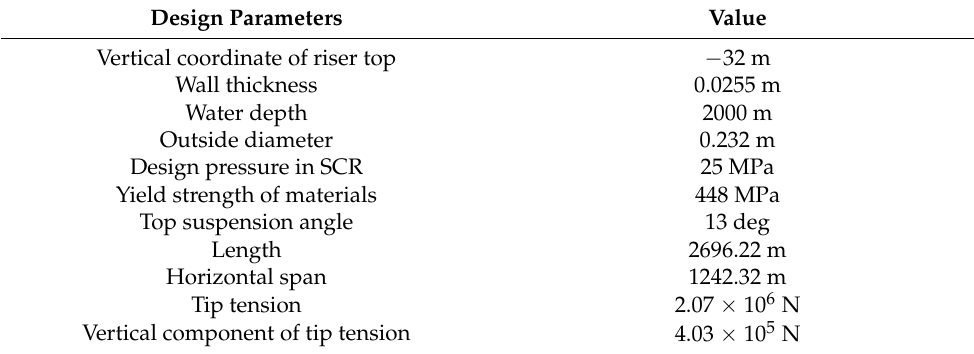
Table 1. Riser design